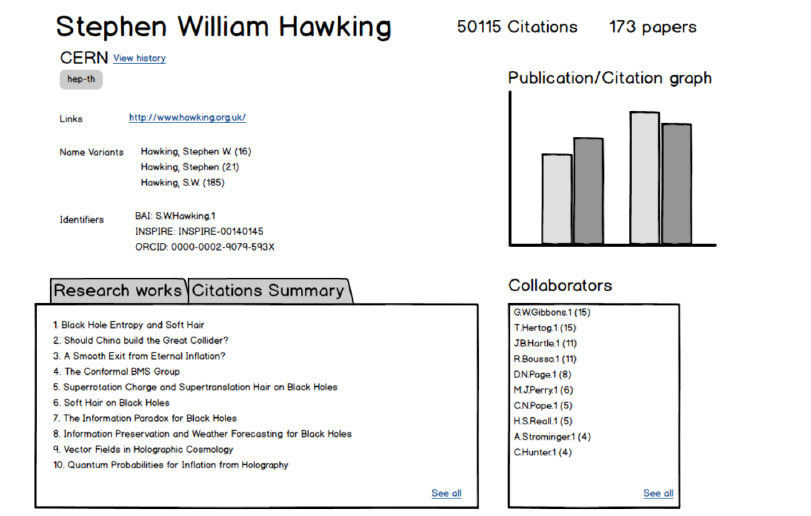
Figure 3. Mockup created following user